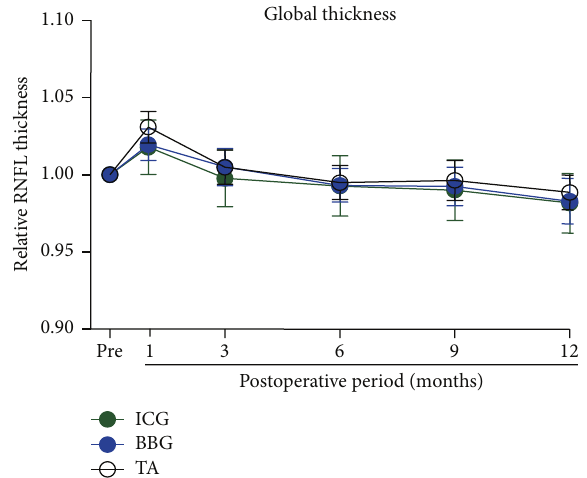
Figure 2: Means of the relative global RNFL thickness are plotted against the postoperative time for ICG, BBG, and TA groups. The RNFL thickness is expressed relative to the preoperative value. Green, blue, and black symbols represent ICG, BBG, and TA groups, respectively. The means ± SEMs. RNFL: retinal nerve fiber layer, ICG: indocyanine green, BBG: brilliant blue G, TA: triamcinolone